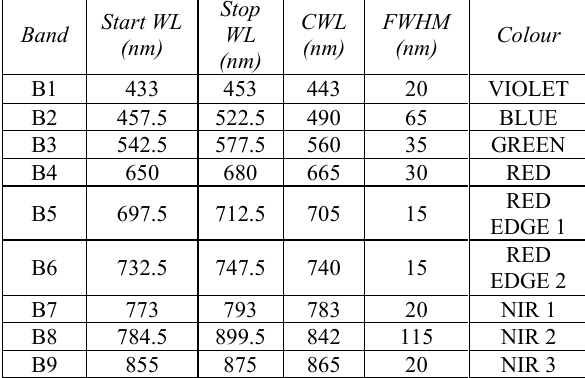
Table 1 . MAIA S2 spectral resolution